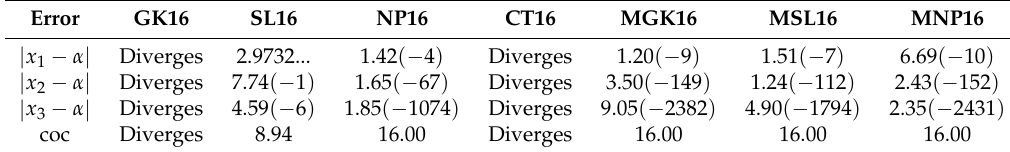
Table 6. Numerical results for f 4 , x 0 = − 0.5.